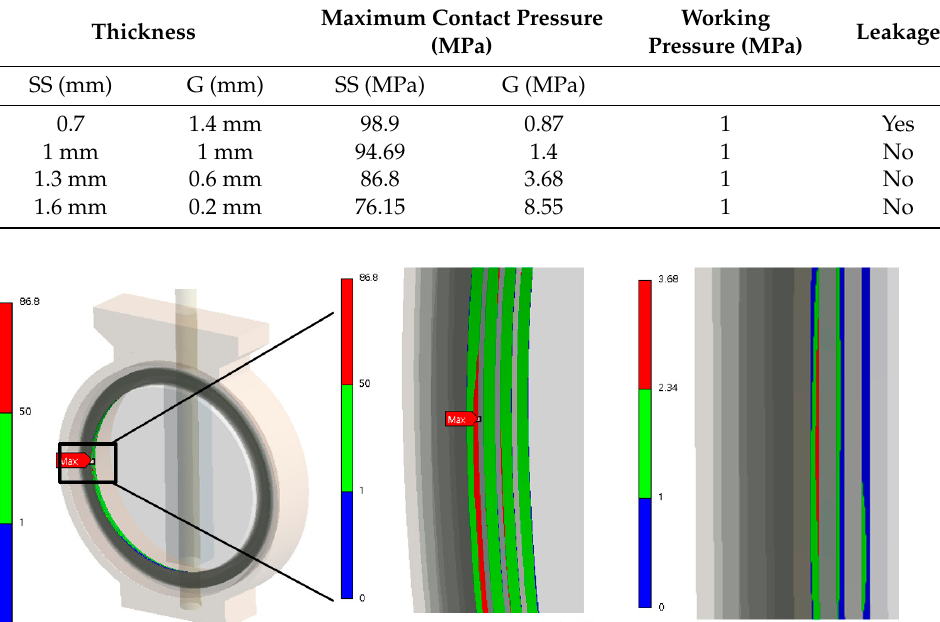
Figure 22. Contact stress distribution of design 4. 3.3. Structural Safety of the Suggested QOBV The structural safety of QOBV with the above design 3 was veri fi ed. The maximum equivalent stress of the main elements in Figure 23 was compared with the allowable strength in Table 6. It is expected to work normally and not yield at 350 °C.